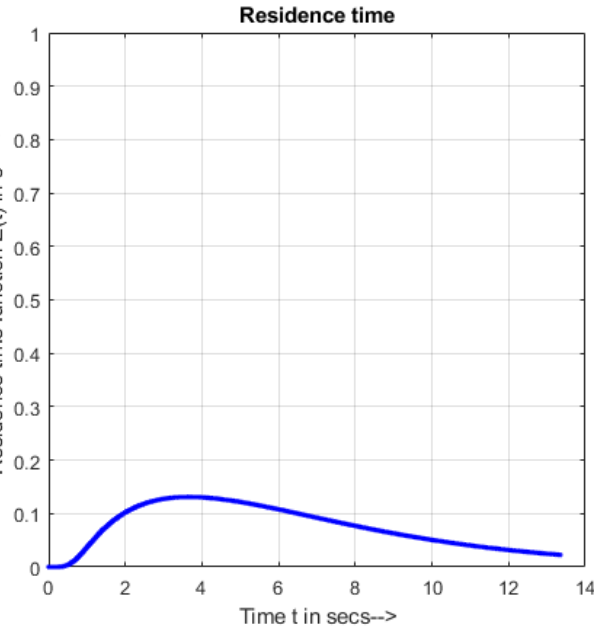
Figure 10. RTD trend obtained from a PBM pulse tracer study for a favorable granulation case from the experimental DOE of Kumar et al., 2016